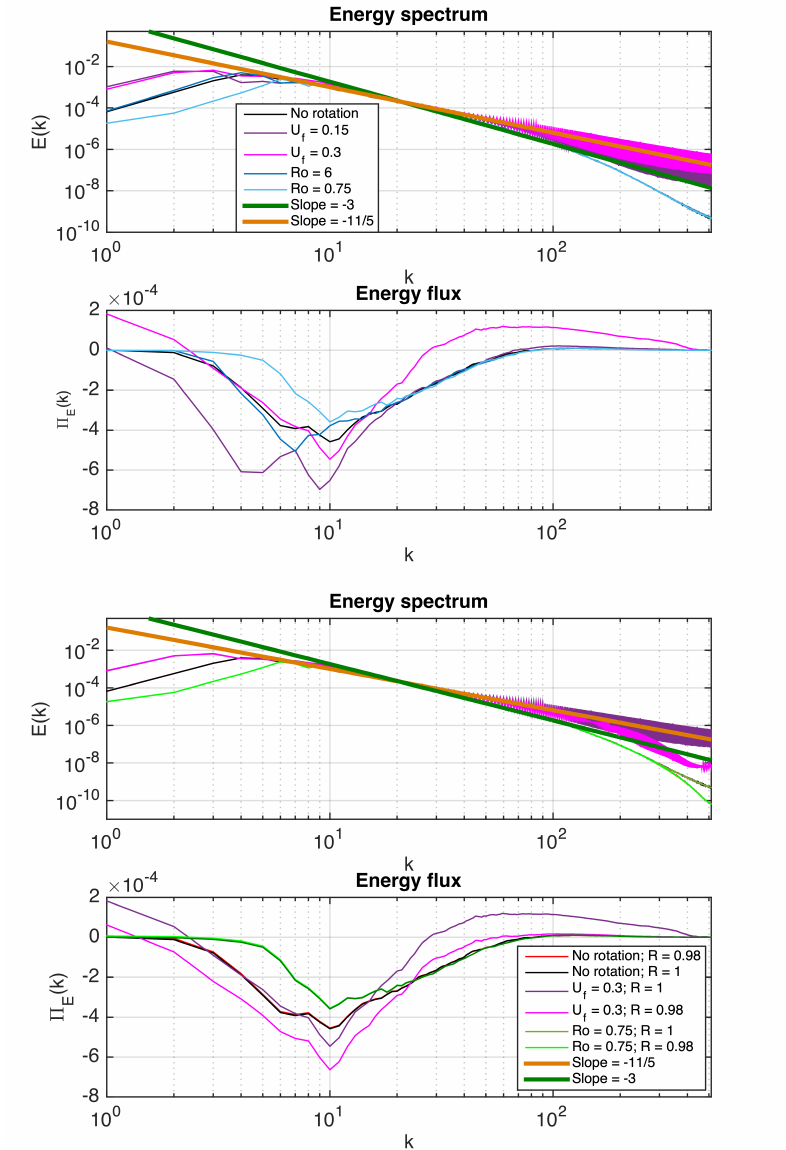
Figure 14. First and second rows: Energy spectra and fluxes for strong, moderate and no rotation for methods 1 and 2. Third and fourth rows: Tukey windowed energy spectra and fluxes for strong rotations. Method 1 with Ro = 0.75. Method 2 with U f = 0.3. Radius of the window R =